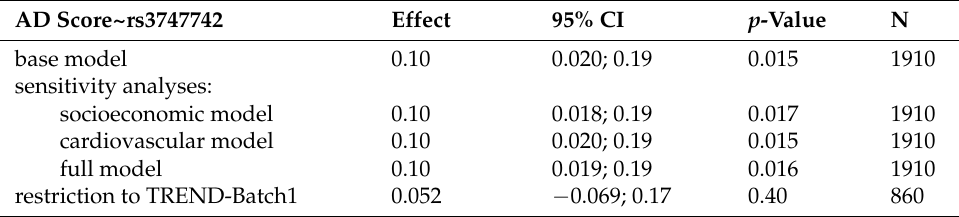
Table 3. The AD score associates with the TREML2 missense variant rs3747742. The base model has been adjusted for age, sex, age × sex, ICV, batch, and the first three genetic principal components. The socioeconomic model has additionally been adjusted for education, income, alcohol intake and partner status. The cardiovascular model is the base model with an additional adjustment for BMI, smoking status, hypertension, serum total/hdl cholesterol ratio and triglycerides. The full model is the base model with additional adjustment for all socioeconomic and cardiovascular